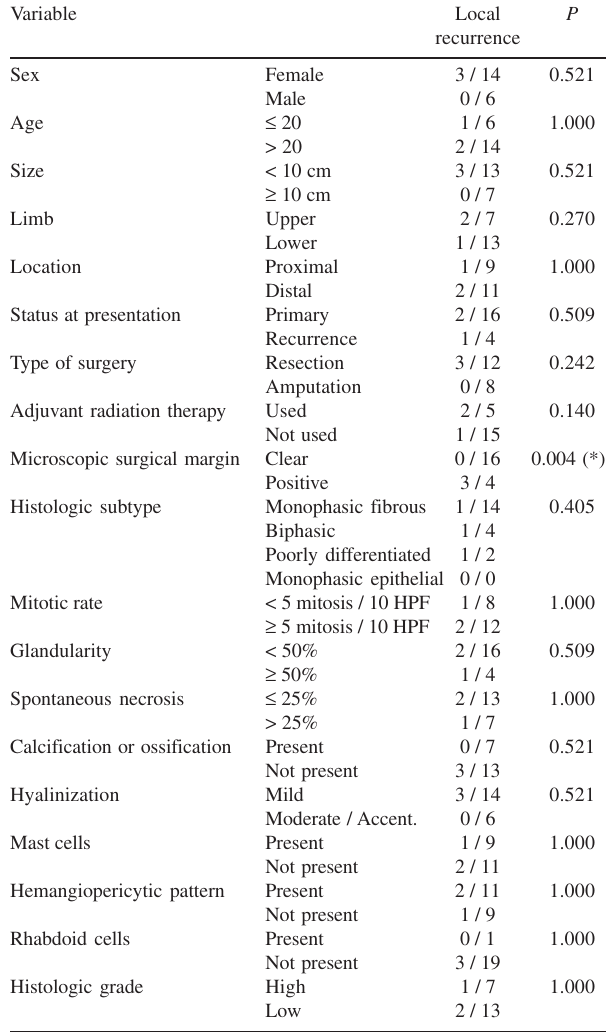
Table 3 - Local recurrence according to all variables